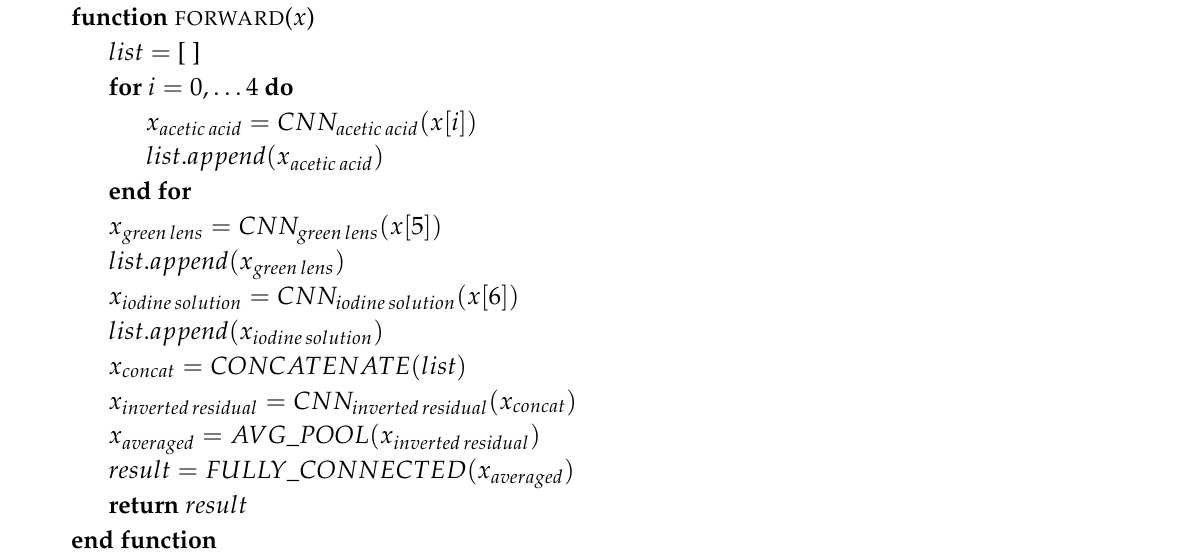
Algorithm 1 Ensemble forward pass. The function parameter x is an array of seven input images. All CNN are functions denoting the forward pass of a specialized convolutional neural network. The CONCATENATE function stacks multiple feature maps, which have the same width and height; for example, stacking two tensors having f eature maps × height × width equal to 32 × 7 × 10 will result in a tensor of size 64 × 7 × 10. AVG _ POOL calculates the average per feature map; for example, pooling a tensor of size 64 × 7 × 10 results in a tensor of size 64. FULLY _ CONNECTED is a function representing the forward pass of a fully connected layer. The resulting tensor is of size 4. Please note that, for simplicity, we did not take into account the batch dimension for tensor